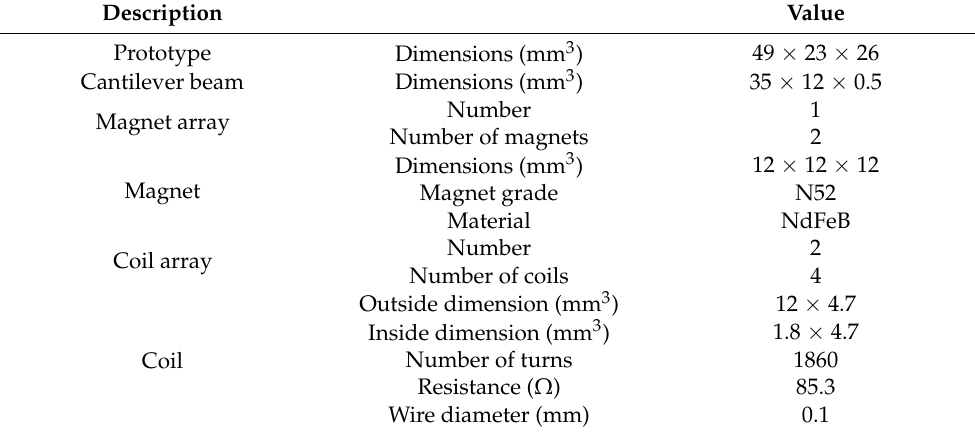
Table 1. Material properties and the geometric parameters of the prototype.